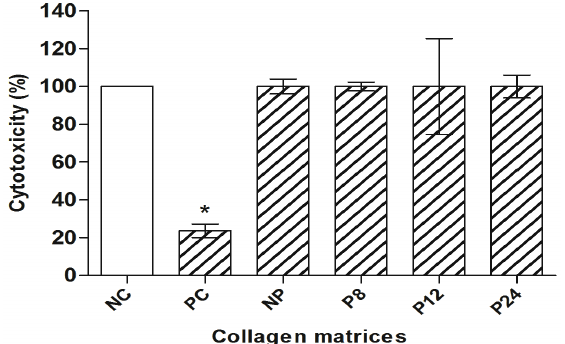
Figure 2. XTT assay in CHO-K1 (cell viability). NC: negative control; PC: positive control. NC represents 100% cell viability. Columns = mean of cell viability (%); bars = standard error. * = p < 0.01 compared to NC, Dunnett’s test.